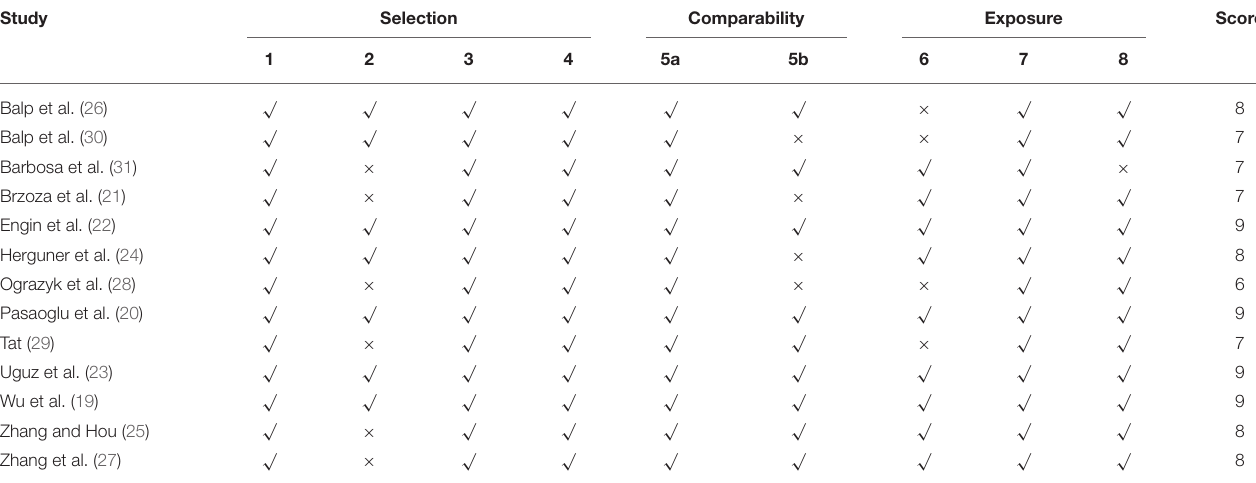
TABLE 2 | Quality assessment of the included studies. Study